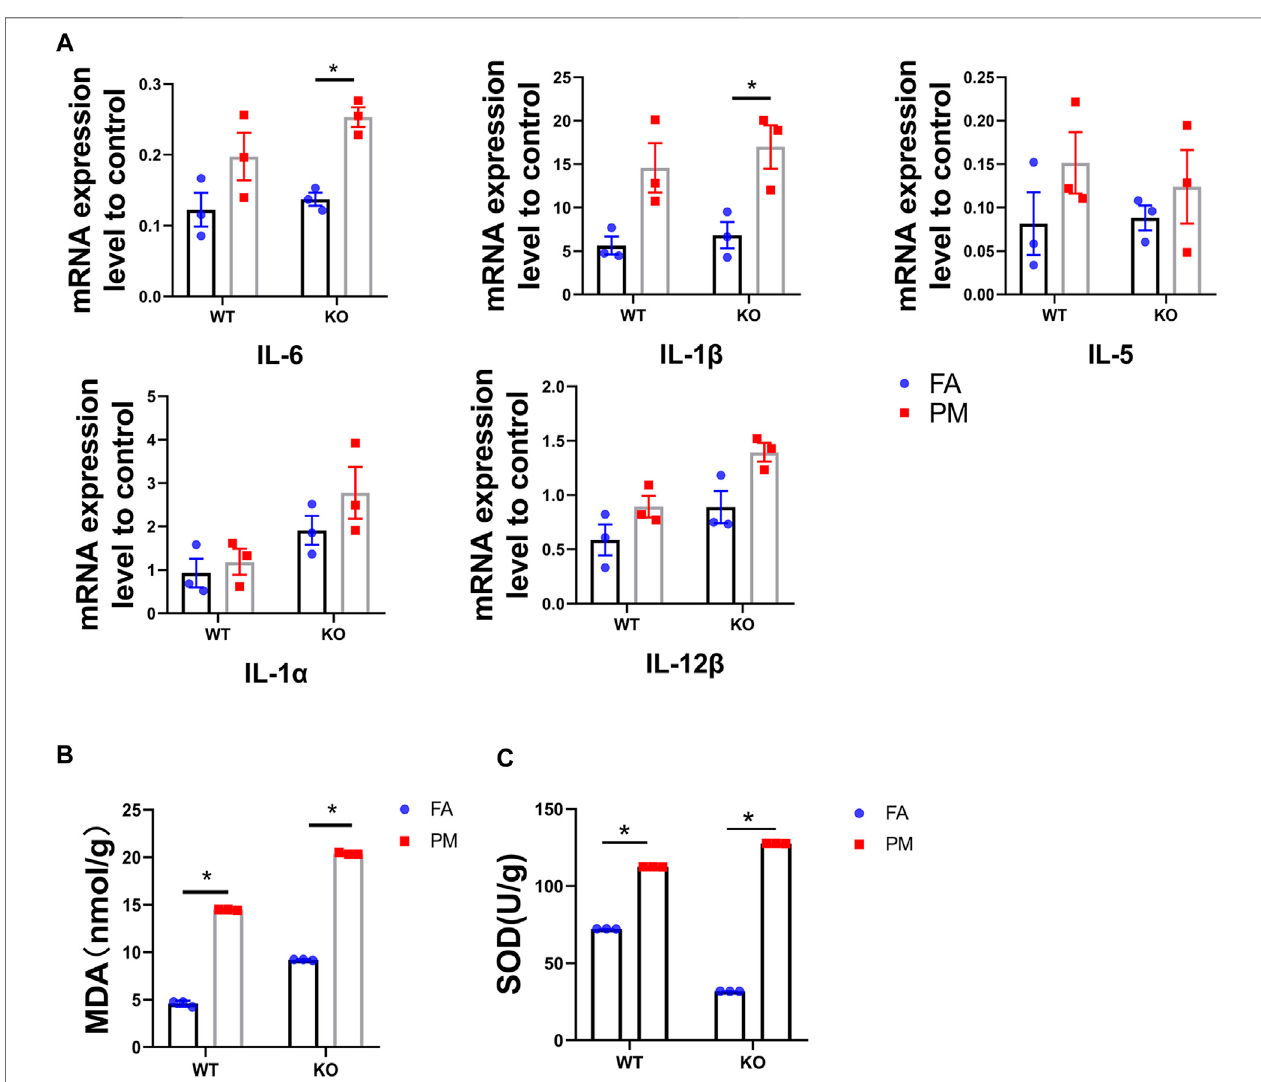
FIGURE2| Nrf2knockoutexacerbatesPM 2.5 -inducedin fl ammationandoxidativestressinlung. (A) Theexpressionlevelofin fl ammatoryfactorsinfourgroups( n (cid:2) 3). (B) MDA contents in four groups. n (cid:2) 3 per group. (C) SOD contents in four groups. n (cid:2) 3 per group. FA, fi ltered air; PM, fi ne particulate matter. WT, wild type mice; KO, Nrf2 − / − mice. Data are expressed as the mean ± SEM, * p <